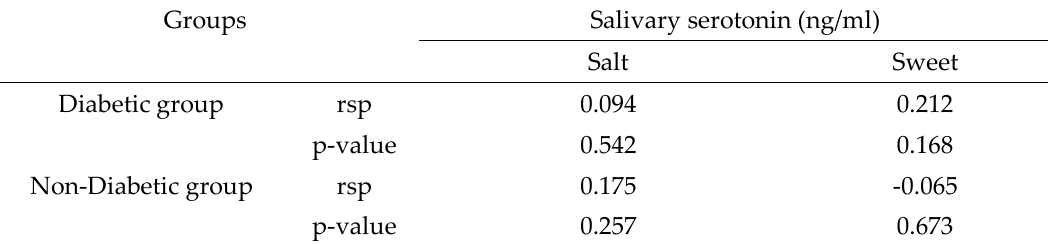
Table (5): The Correlation between salivary serotonin and sweet and salt taste thresholds among diabetic